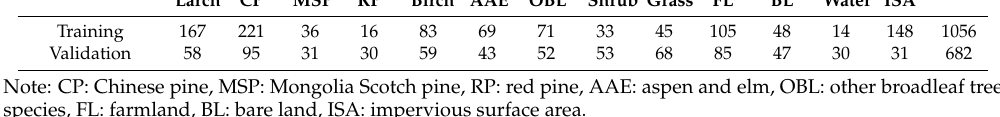
Table 4. Summary of samples for training and validation for each land cover class. Number of Samples for Each Samples